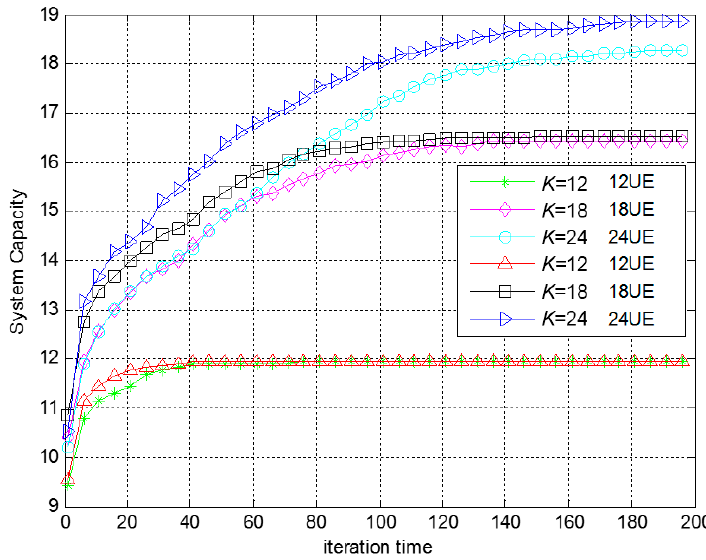
Figure 5. The comparisons of convergence between RPSO and SPSO. Table 3. The comparisons between RPSO, SPSO and Rand.